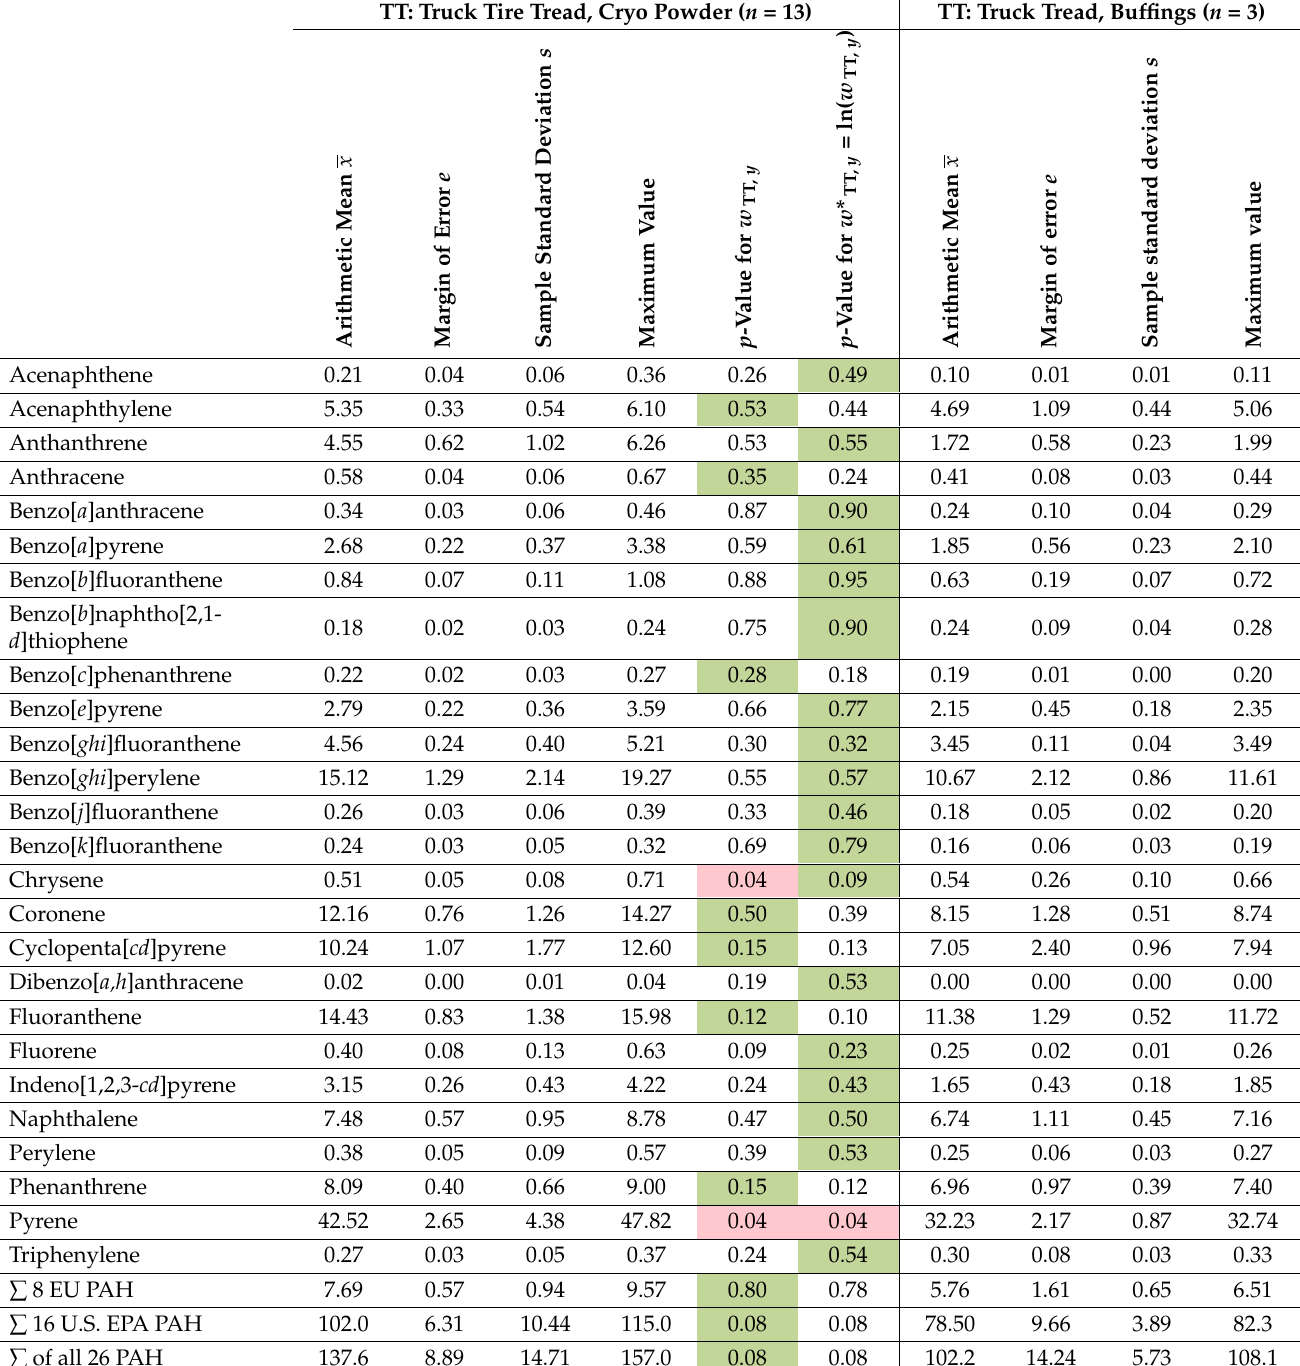
Table 4. Statistical indicators for truck tire tread (TT). TT: Truck Tire Tread, Cryo Powder ( n =